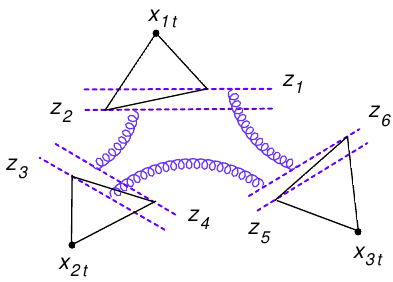
Figure 10 . The structure of correlator (6.25). Straight lines denote \propagators" ( z 2 (( x i (cid:0) z j ) 2 ) (cid:21)